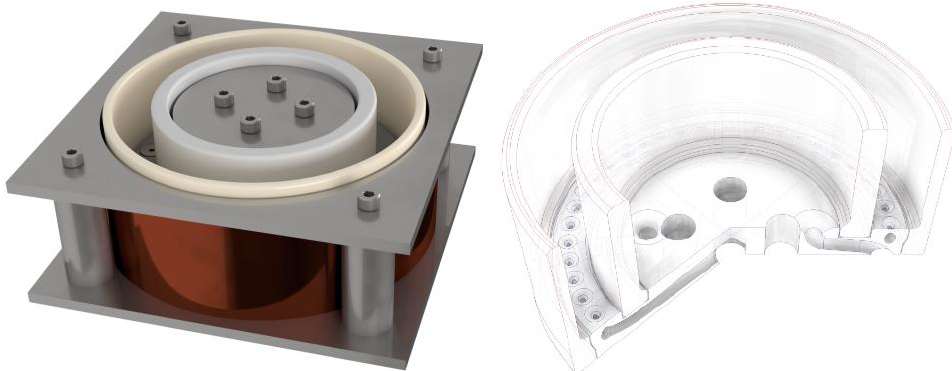
Figure 2. 3D rendering of UAH-78AM configuration as tested at GRC and a cross-section of the discharge channel with embedded propellant distributor and inner and outer channel walls.